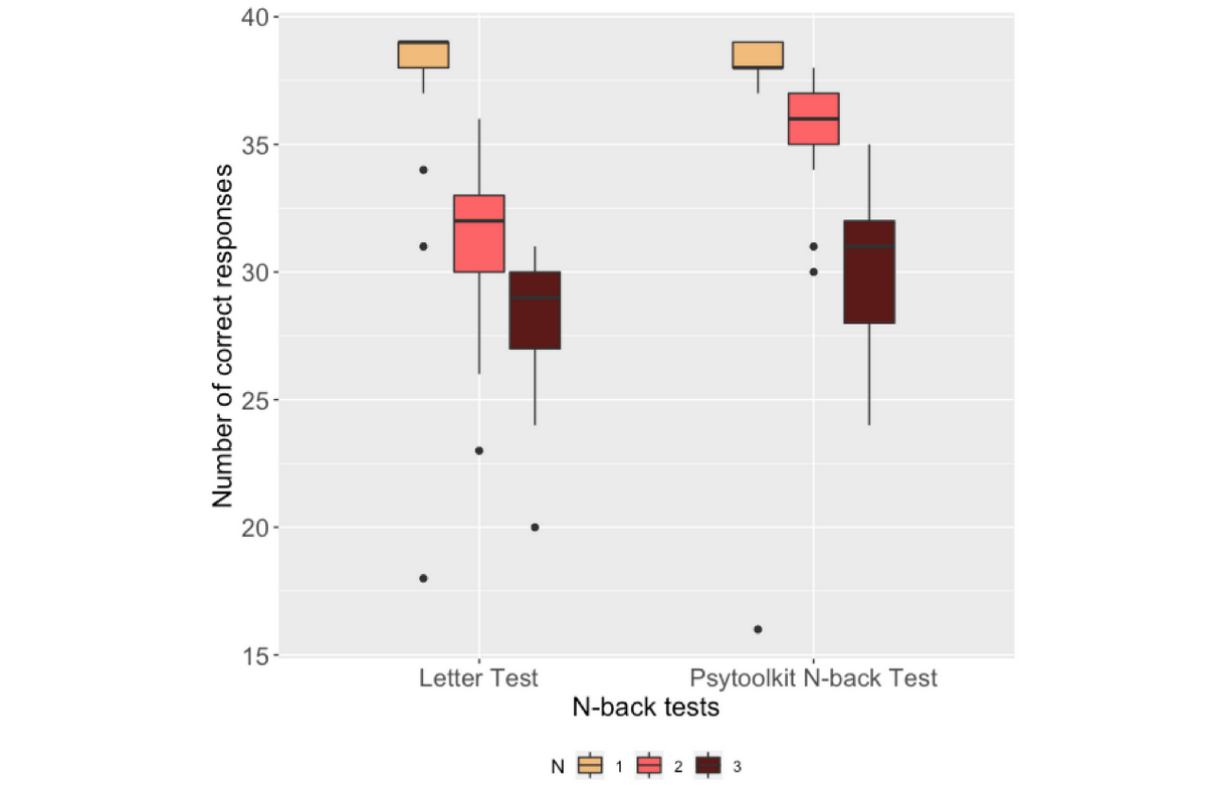
Figure 8. Box plots of participants' number of correct responses in the N-back tests.